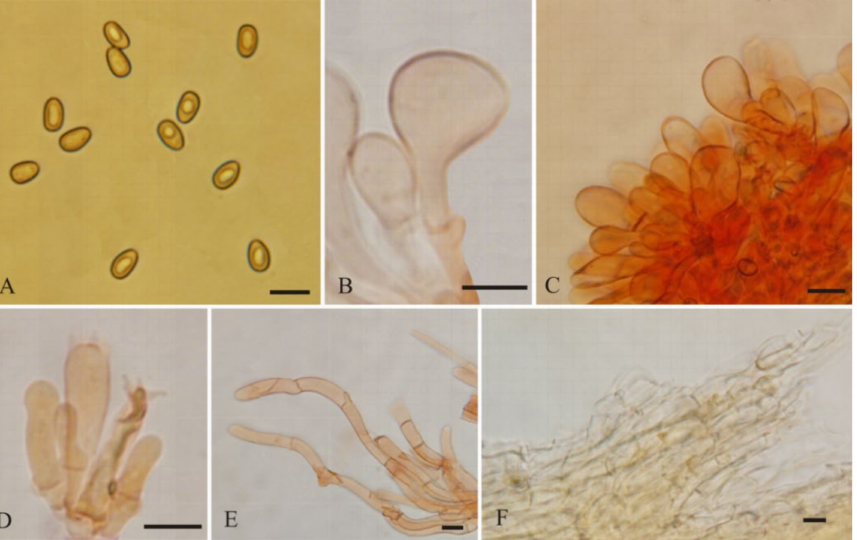
Figure 4. Mallocybe depressa (BJTC FM1695). ( A ) Basidiospores, ( B , C ) Cheilocystidia, ( D ) Basidia, ( E ) Caulocystidia, ( F ) Pileipellis. Scale bars: ( A – F ) = 10 µ m. MycoBank: